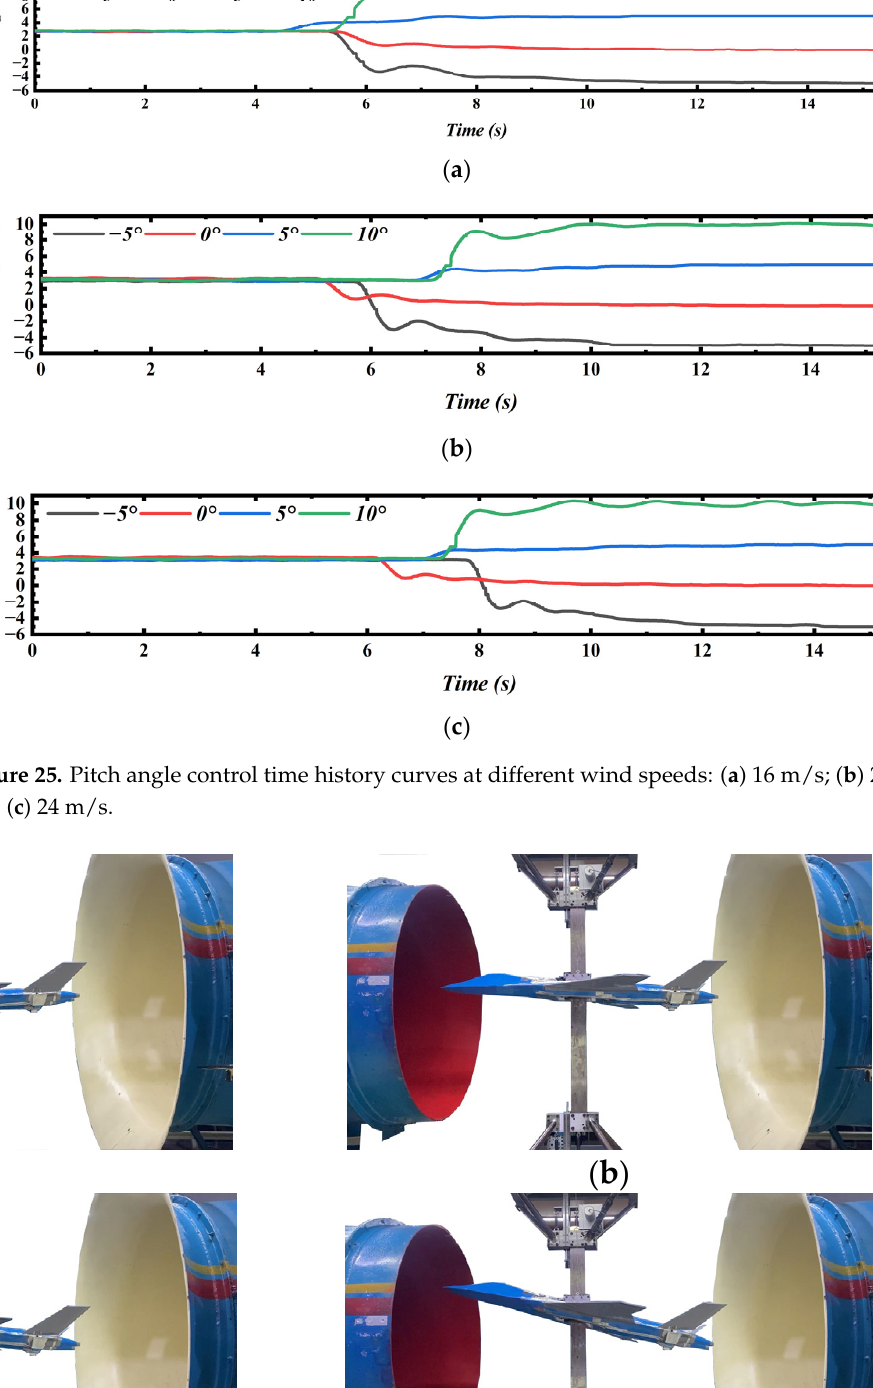
Figure 26. Captures when the model reached different target pitch angles: ( a ) − 5 °; ( b ) 0 °; ( c ) 5 °; and ( d ) 10 °.